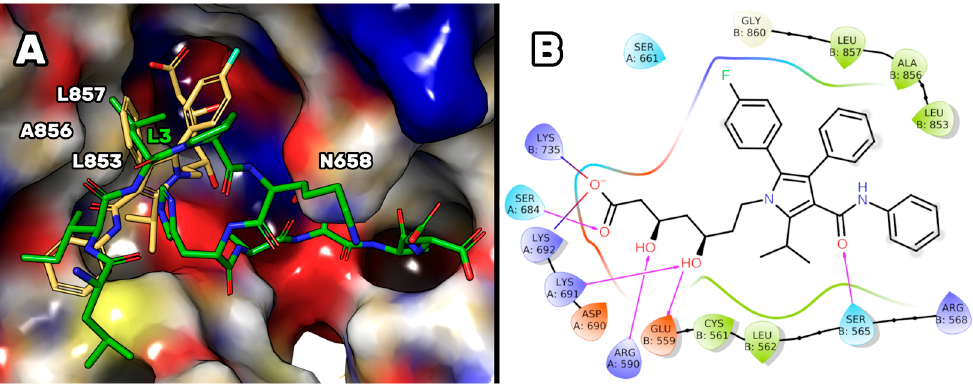
Figure 9. ( A ) Crystallographic pose of atorvastatin (yellow sticks), as was found in the X-ray structure available in the PDB (accession code 1HWK [51]), superimposed on the representative structure of the most populated cluster of P5-S7A (green sticks) in complex with HMG-CoAR. ( B ) 2D representation of the protein-ligand contacts displayed by atorvastatin (cutoff = 3.00 Å) in complex with HMG-CoA, as in the X-ray structure. H-bonds are highlighted by purple arrows and the hydrophobic residues involved in the protein-ligand interactions are colored in green.